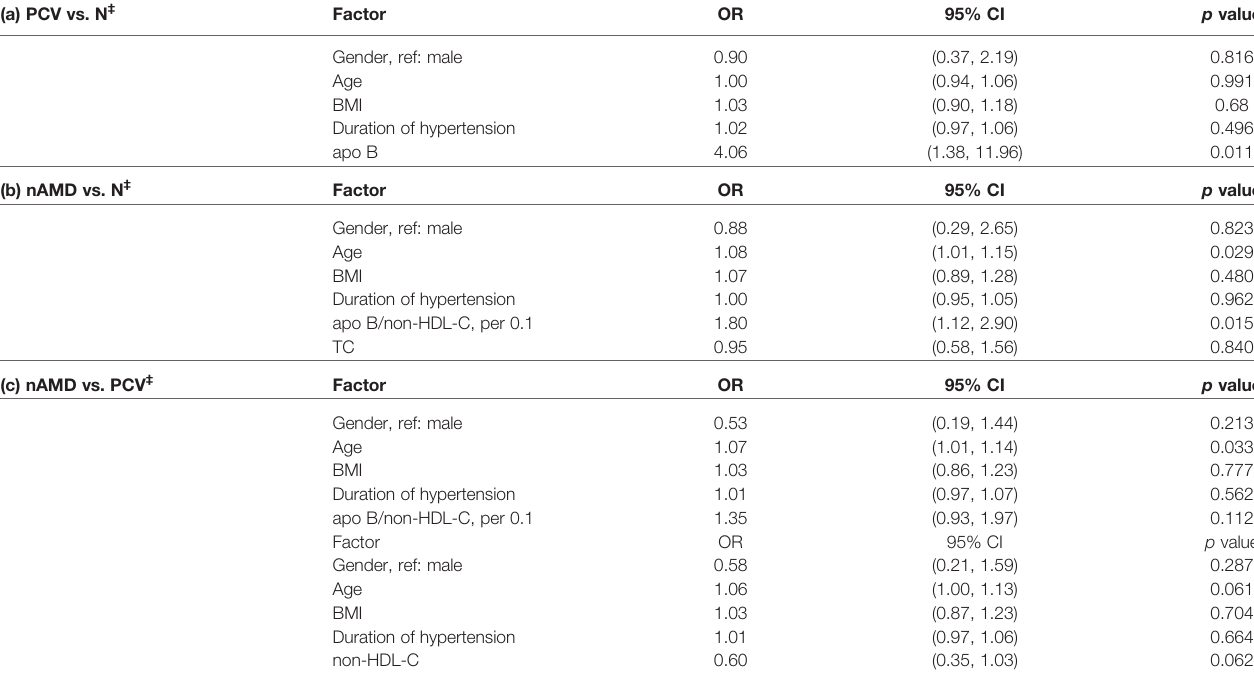
TABLE 5 | Comparisons in the lipid pro fi les and apolipoproteins between PCV, nAMD and control by multivariable logistic regression analysis. (a) PCV vs. N